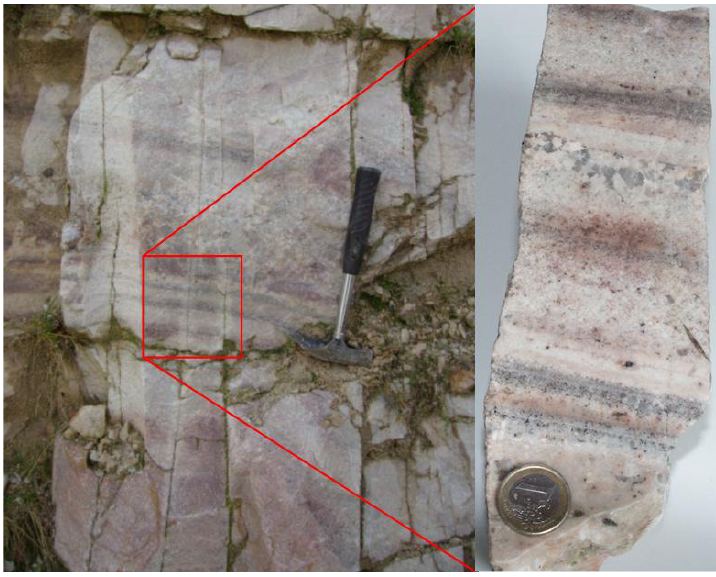
Figure 3. Magmatic layering of alkali - feldspar syenite, Vysoký Kámen stock.